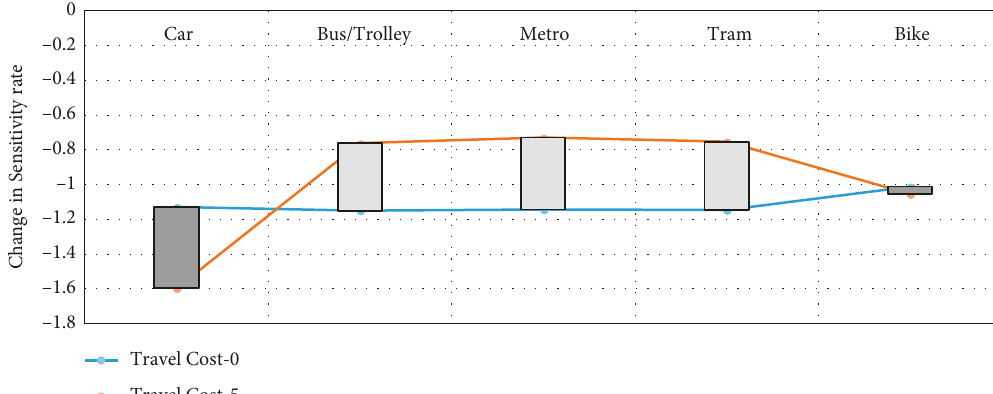
Figure 2: A comparison between the coefficients of the mode choice based on changing the travel